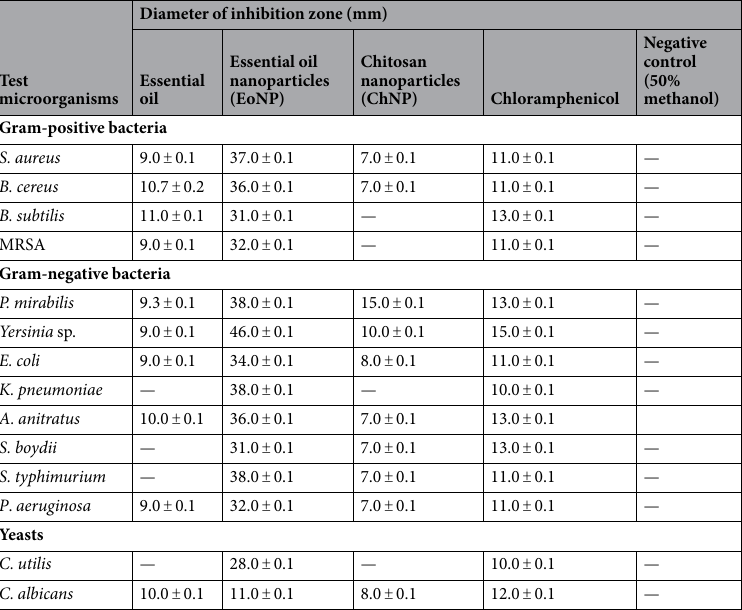
Table 2. Antimicrobial activities of H. pineodora essential oil, EoNP and ChNP on disc diffusion assay tested on various diabetic wound pathogens.